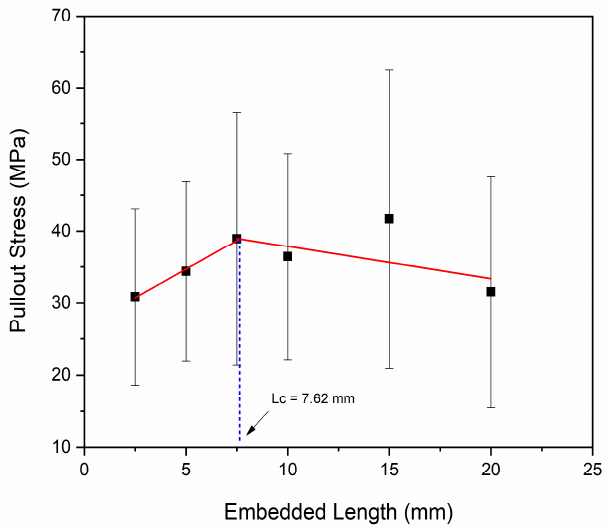
Figure 9. Interfacial pullout strength between the epoxy matrix and TVFs, as a function of embedded length.